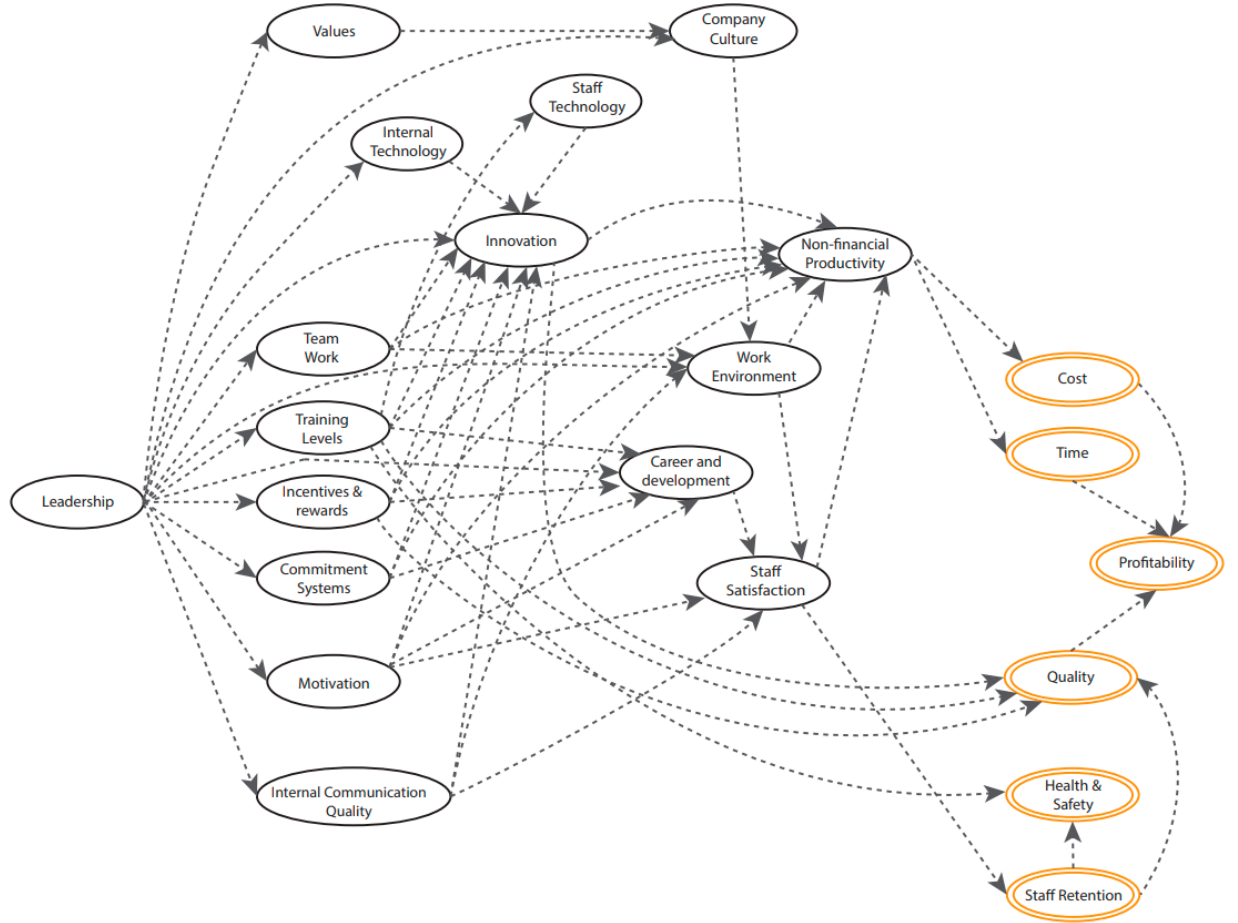
Figure 3. Proposed Model: Interrelationship of HR and competitiveness.